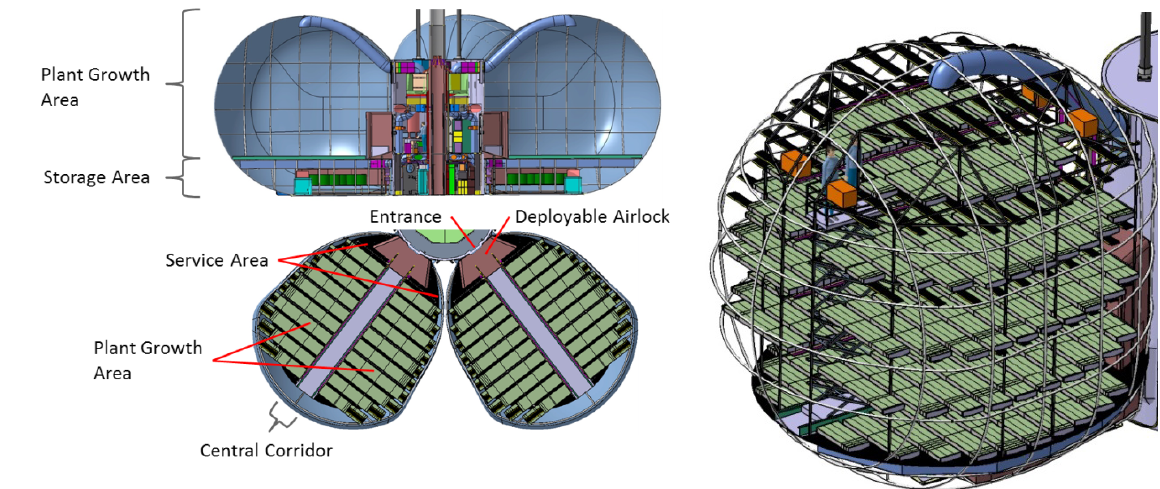
Figure 6: Left Top: Side view of the GHM in its final version; Left Bottom: Top view of two petals in their final version, Right: Petal configura- tion (inside view).